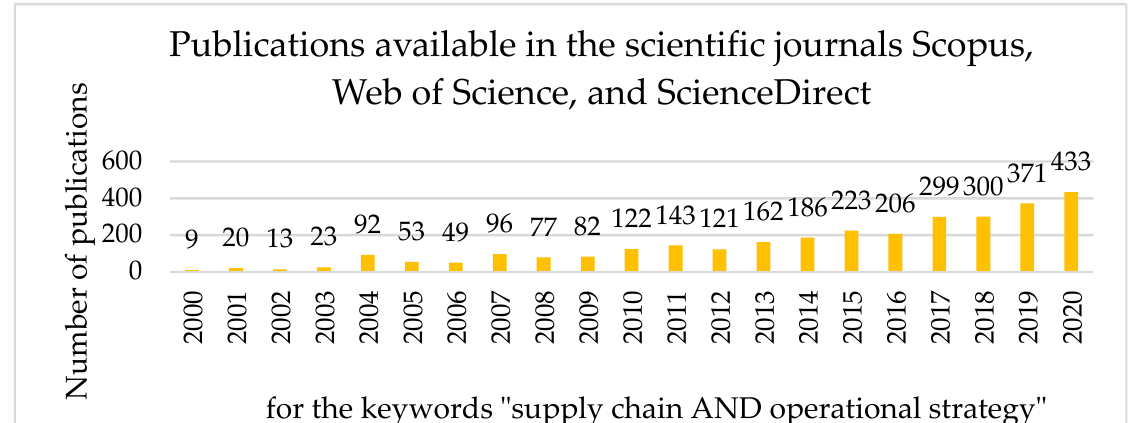
Figure 1. Number of publications related to the topic by year of publication (Source: Self-edit).